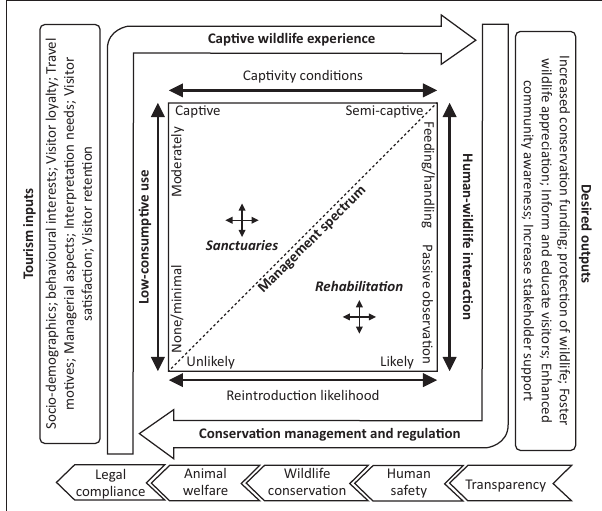
FIGURE 1: Captive wildlife management